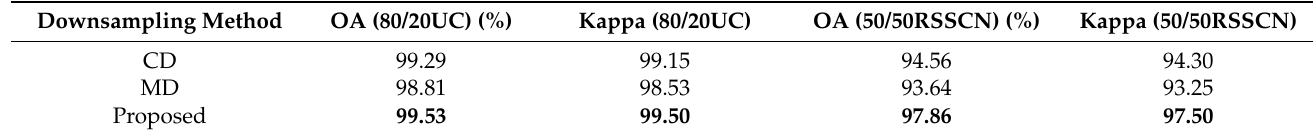
Table 10. Comparison results of OA and Kappa of three downsampling methods on UC and RSSCN datasets. Downsampling Method